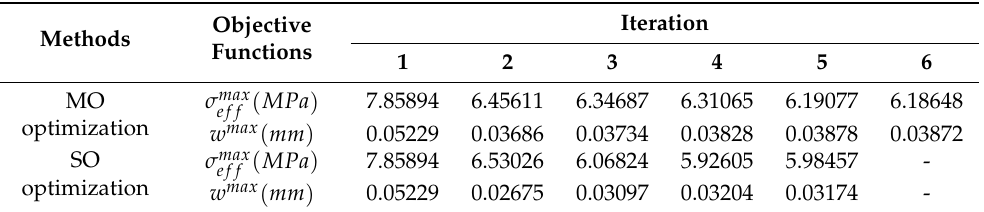
Table 6. Comparison of iteration histories between MO and SO optimizations.